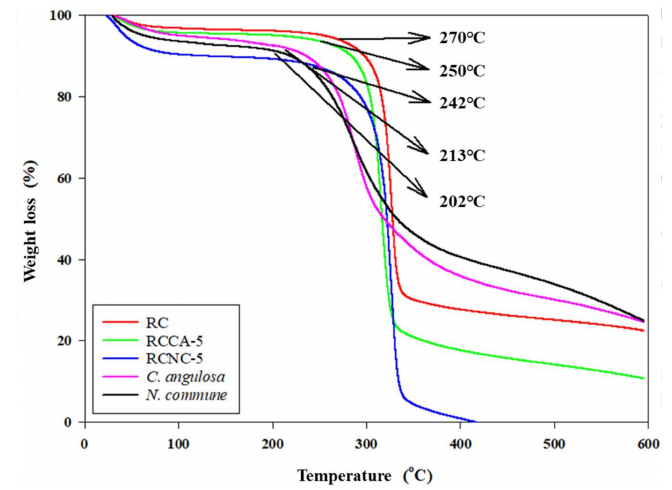
Thermogravimetric curves showing the decomposition of the raw materials (RC, Chlamydomonas angulosa , and Nostoc commune ) and the manufactured composites (RCCA-5 and RCNC-5) at 10 ◦ C/minute heating